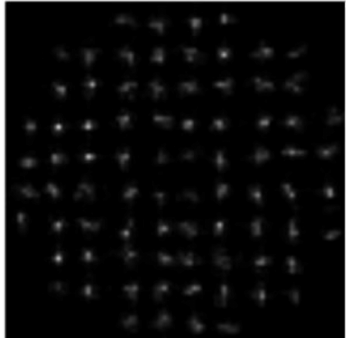
Figure 1. Example of the light received by the Shack–Hartmann wavefront sensor in an SCAO configuration with only one star on axis. A significant magnitude that is measured by the SH is the centroid of each subaper- ture. It corresponds with the gravity center of the spot received and it is commonly used by the sensor to calculate the slopes of the received wavefront. The slopes are the main information used by most RS systems to reconstruct the original wavefront, as in the case of the RS based on MLPs ANNs or the LS RS. That is not the case of the CNNs or our new FCNs, considering the properties of using all the image received by the SH. This means that they make the most of all the information received instead of the other RS where only two values of each subaperture are used. These methods allow to have no loss of infor- mation avoiding pre-processing data process.